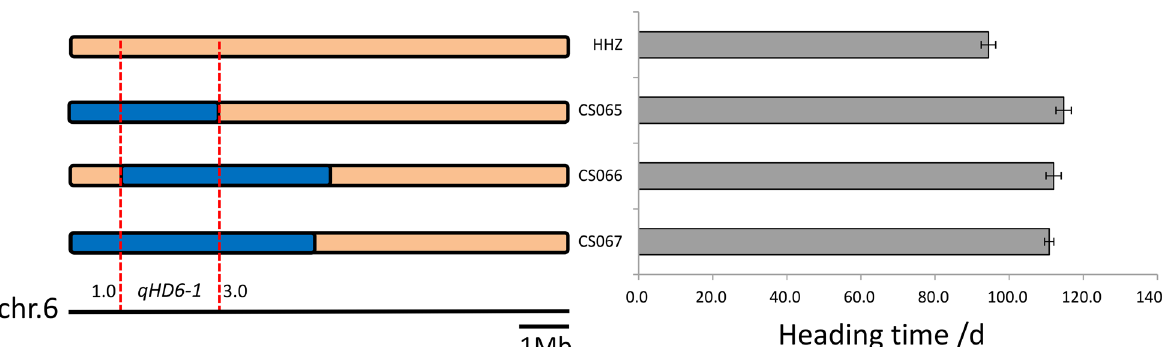
Fig. 5 The genomic interval found in the progeny homozygous for qHD6-1 delimited the locus to an ~ 2.0 Mb region. Different colors represent different genotypes: orange, HHZ; blue, BAS. Red dashed lines indicate the overlapping regions in different CSSLs. Heading date is shown for recombinant plants (CS065, CS066 and CS067) and the parental plants. Heading date values (in days) are shown as the means (n =